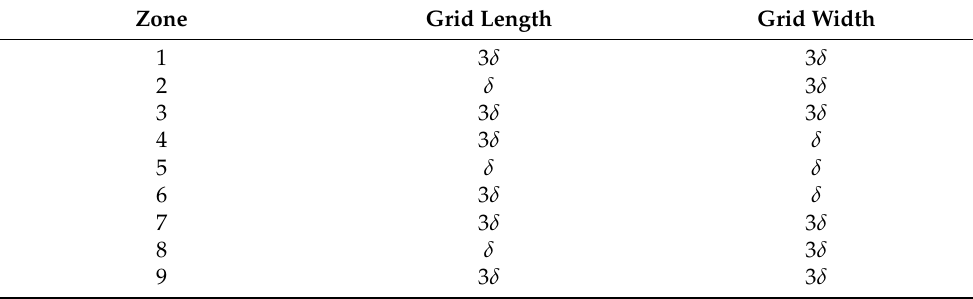
Table 2. Grid sizes in nine zones.